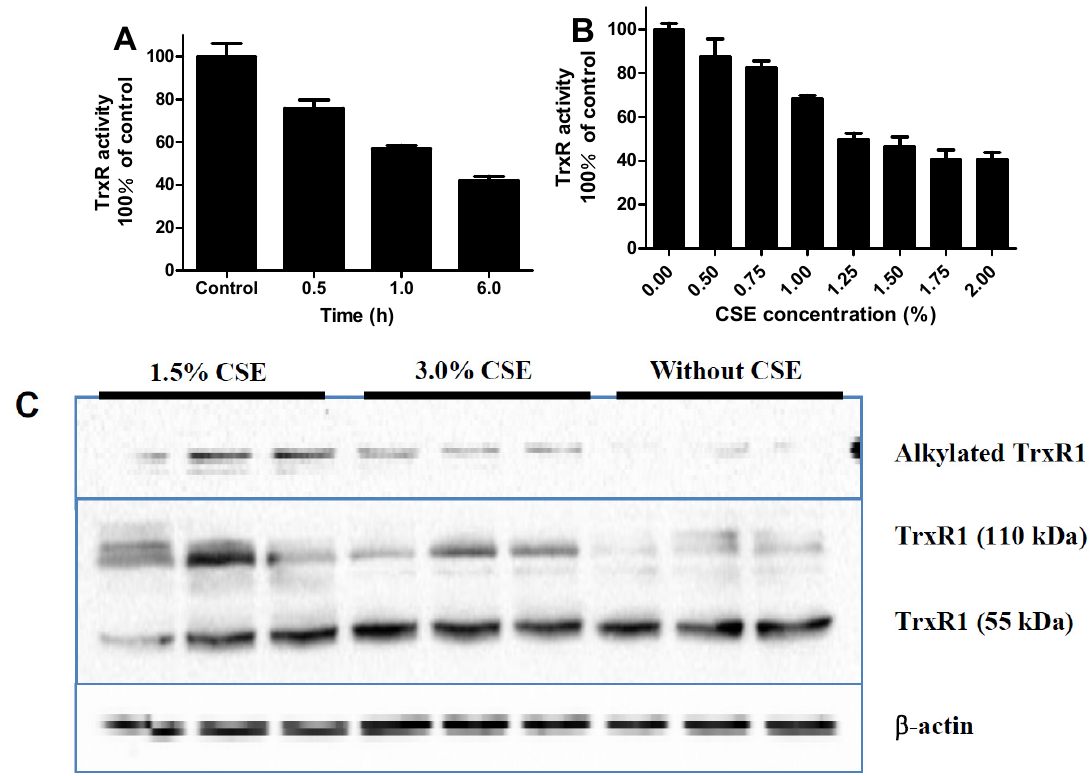
Figure 6. Impact of cigarette smoke extract (CSE) on intracellular TrxR; ( A ) time-dependent alteration of TrxR activity in Tca-8113 cells treated with 1.5% CSE; ( B ) dose-dependent alteration of TrxR activity in Tca-8113 cells treated with CSE for 1 h; ( C ) TrxR1 protein in Tca-8113 cells treated with CSE for 2 h. Basal TrxR activity was 10.1 and 10.4 (mU/mg protein) in A and B, respectively. Data are presented as means ± SEM ( n = 2 in A and 3 in B and C).